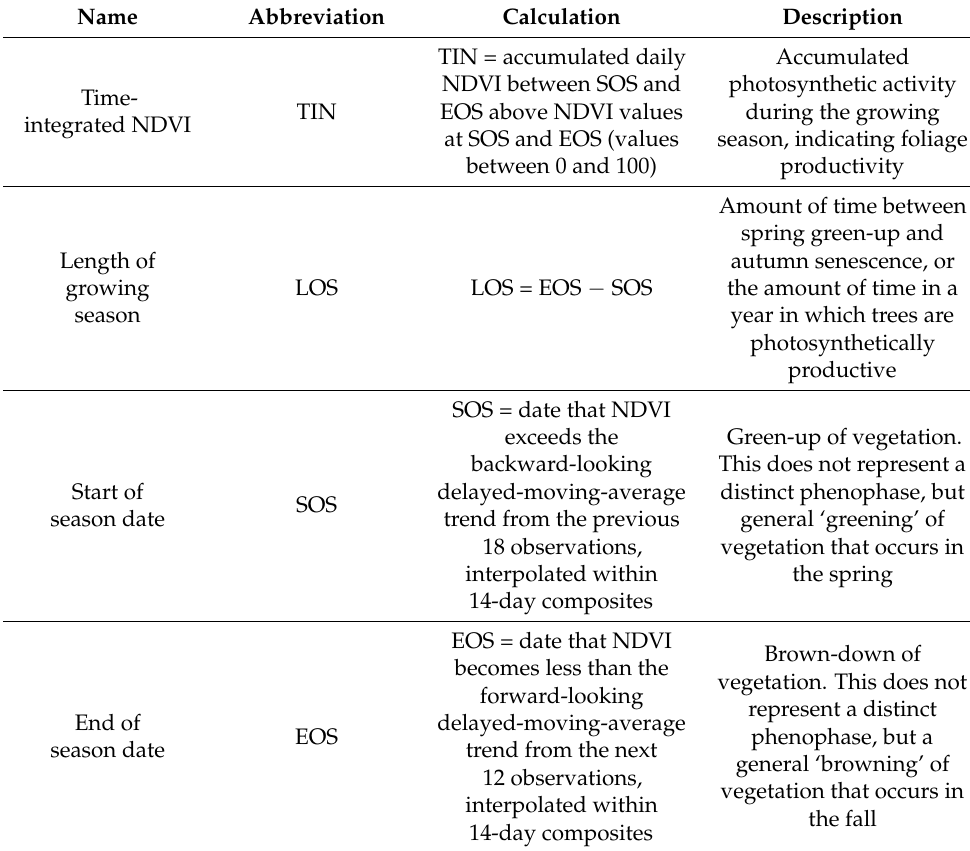
Table 1. Forest growth indices selected from the USGS AVHRR phenology database. Data are accessible from https://www.usgs.gov/land-resources/eros/phenology, (accessed on 4 January